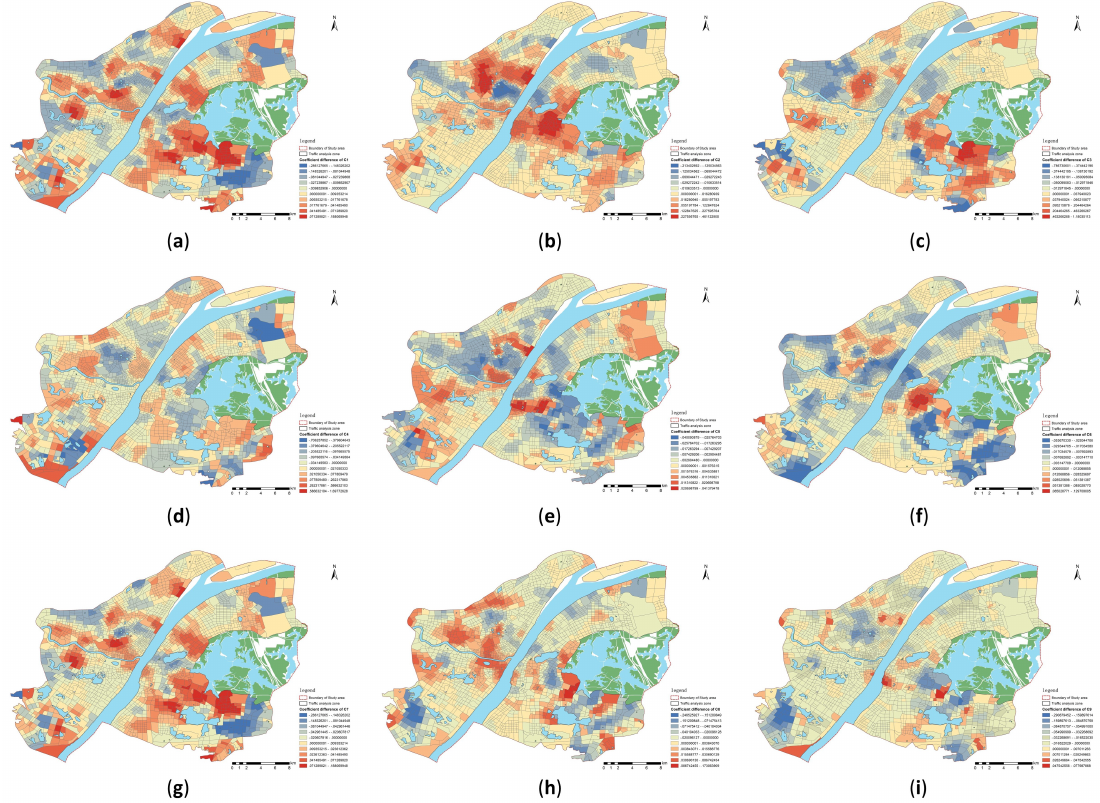
Figure 21. Spatial distribution of regression coefficient differences. ( a – i ) represent the regression coefficient differences of each